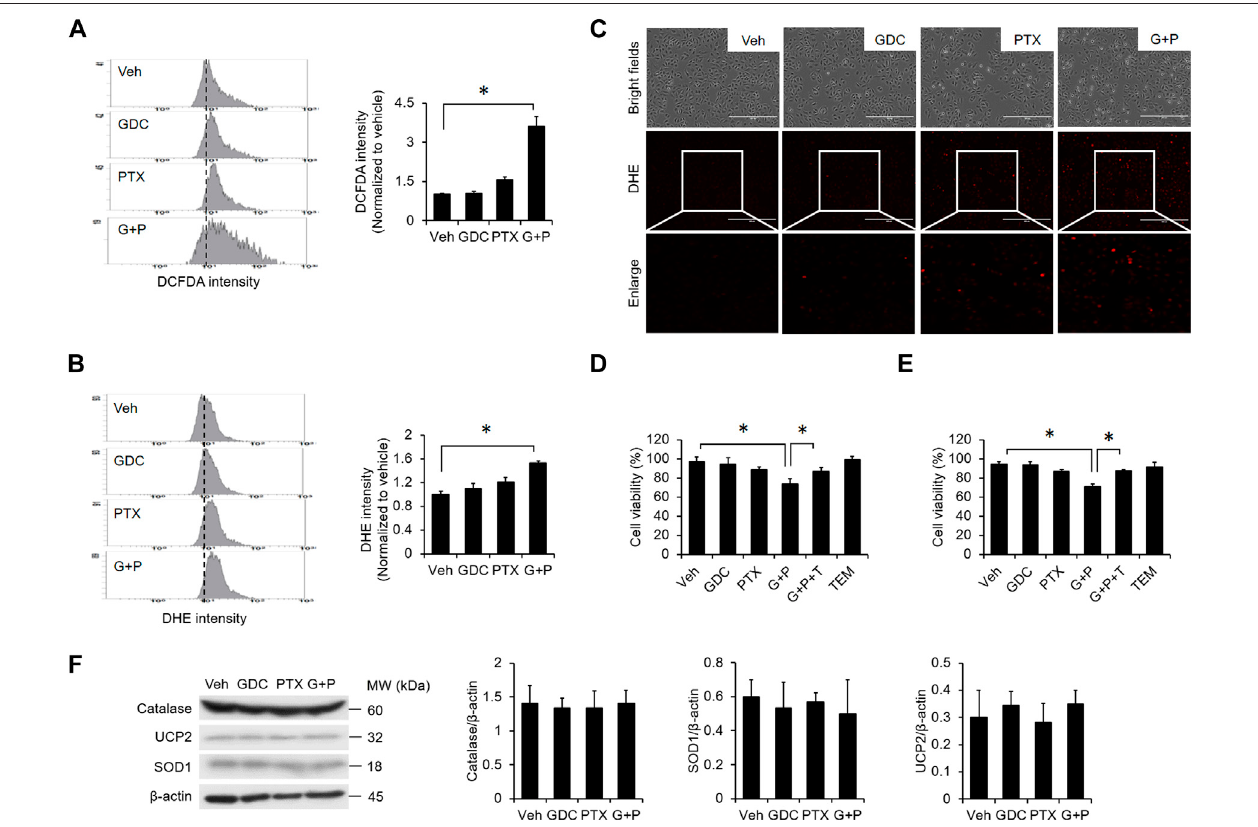
FIGURE 5 | ROS generation is enhanced by the combination of PTX and GDC. A549 cells were preincubated with GDC (20 μ M) for 1 h followed by PTX (20 nM) treatment for 24 h. Intracellular ROS levels were monitored by DCFDA (A) and DHE (B,C) . A549 (D) and H1299. (E) A549 cells were treated with GDC (20 μ M) and PTX (20 nM) for 24 h, with or without preincubation with the mitochondrial ROS scavenger, mitoTEMPO (TEM; 10 μ M). Cell viability was assessed by trypan blue exclusion assay. G + P, GDC + PTX; G + P + T, GDC + PTX + TEMPO. (F) Cells were treated as in (A) ; total cell lysates were immunoblotted with anti-catalase, anti-UCP2, anti-SOD1, and anti- β -actin antibodies. G + P, GDC + PTX. Protein band intensities were analyzed using ImageJ. G + P, GDC + PTX. *: p < 0.05; indicates a statistically signi fi cant difference between indicated groups. All experiments were performed at least three times. n = 3 for all